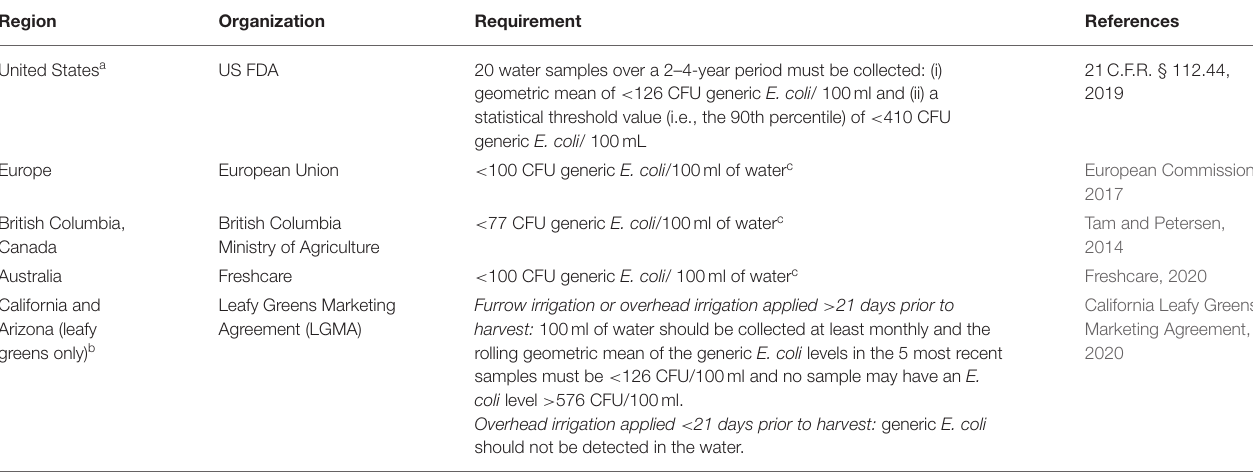
TABLE 1 | Microbial quality requirements or regulations established in different countries or regions for agricultural water applied to pre-harvest produce.